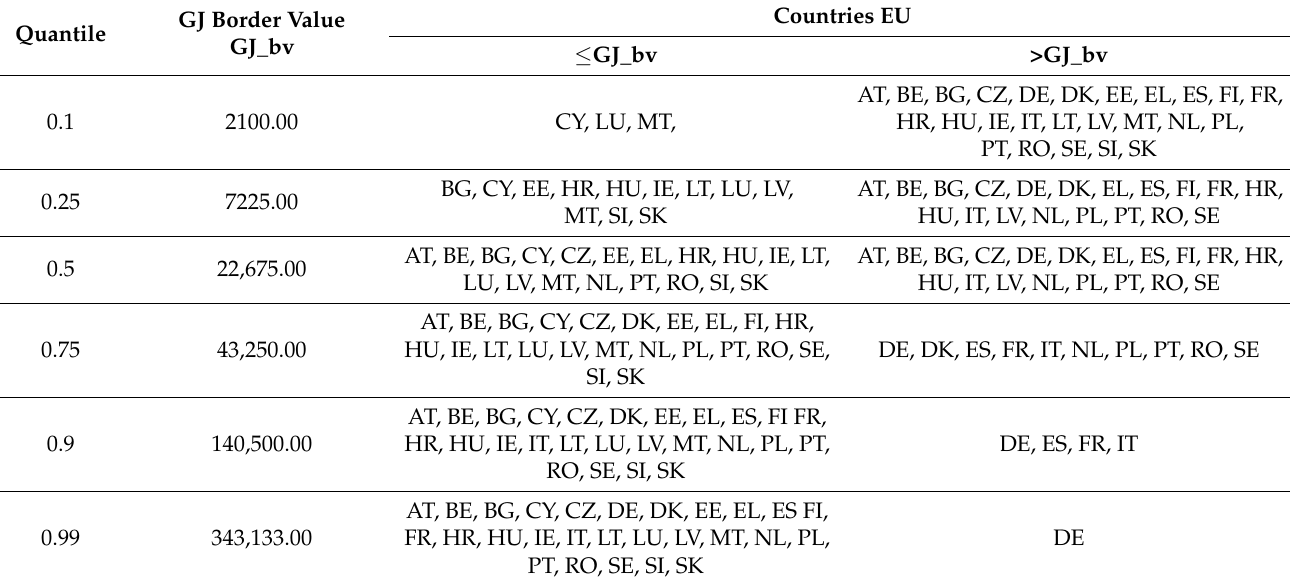
Table 4. Results of quantile analysis for green jobs in EU countries in the years